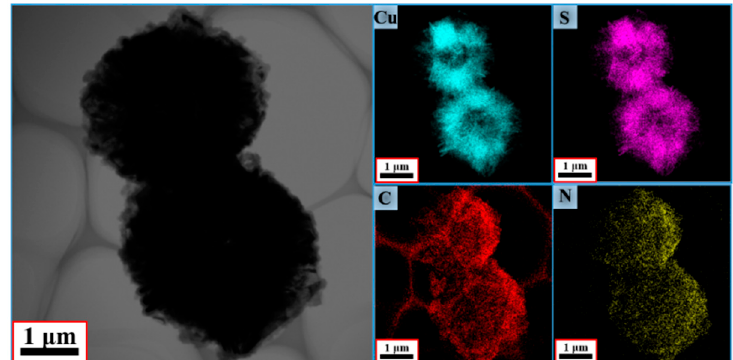
Figure 3. Elemental mapping images of Cu, S, C, and N.